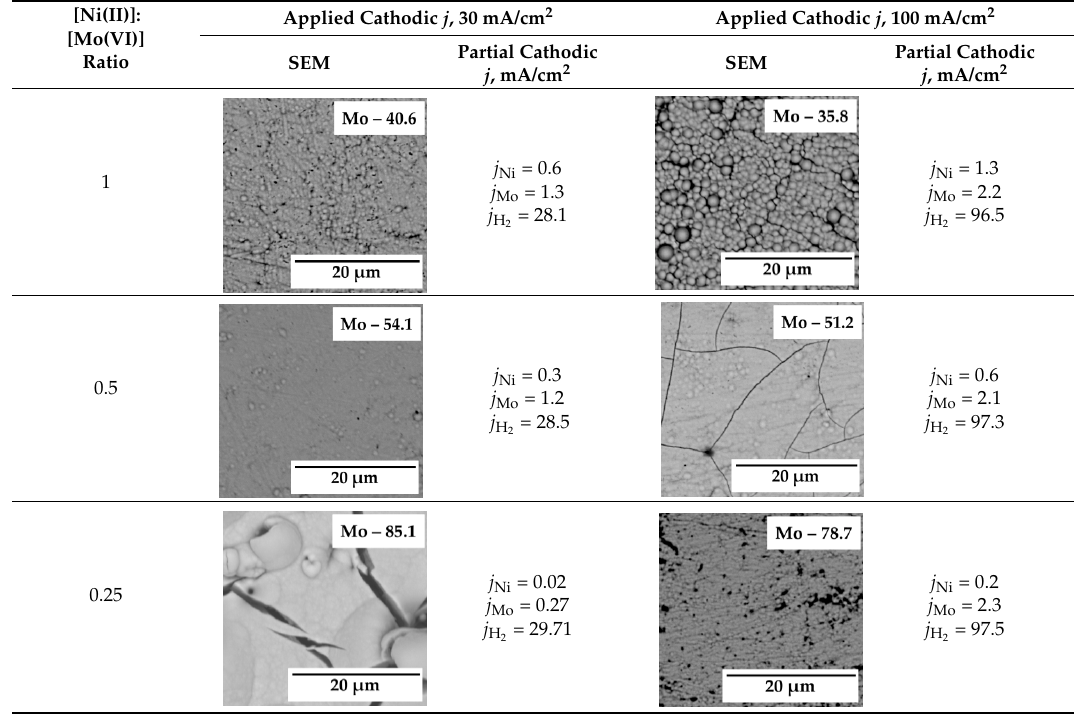
Table 2. Dependence of composition, morphology and partial current densities of electrodeposited Ni–Mo alloys on the [Ni(II)]:[Mo(VI)] ratio and applied cathodic current density. Molybdenum at.% content is specified on the SEM images.